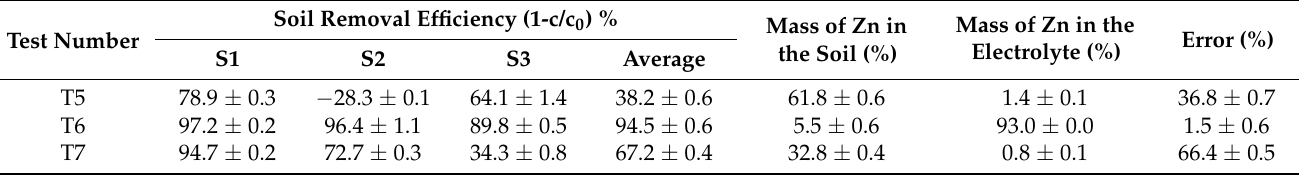
Table 4. Zn removal efficiency in the soil sections and mass balance for T5, T6, and